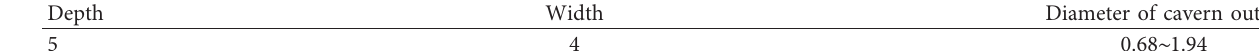
Table 4: Geometric parameter of cavern and outlet.